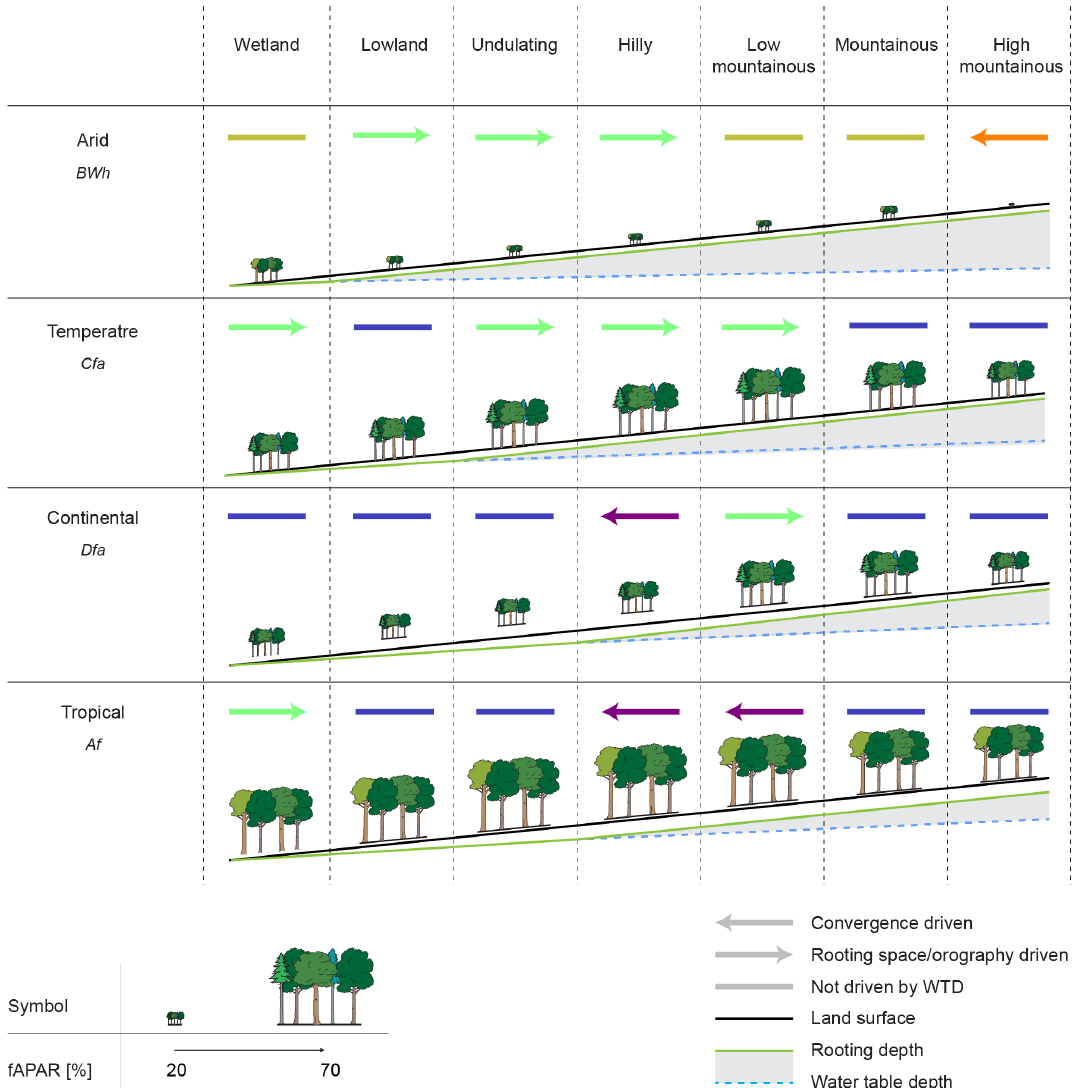
Figure 7. Conceptual framework summarising the links between fAPAR, water table depth, the correlations and implications for the patterns of rooting depth across climate and landscape classes. Different percentages of fAPAR are depicted as tree symbols, the ecohydrological classes are shown as arrows, where the colours represent the classes, and the point of the arrow indicates the sign of the correlation between WTD and